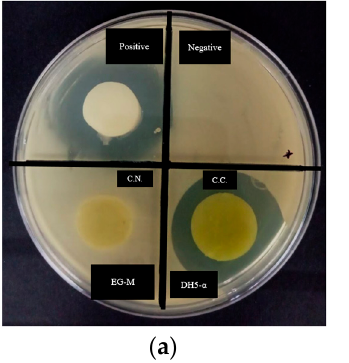
Figure 13. Antibacterial activity of the extract-loaded hydrogels with ( a ) EG − methanolic/NRC and EG − methanolic/MCC, ( b ) EG − ethanolic/NRC and EG − ethanolic, and ( c ) WE/NRC and WE/MCC.